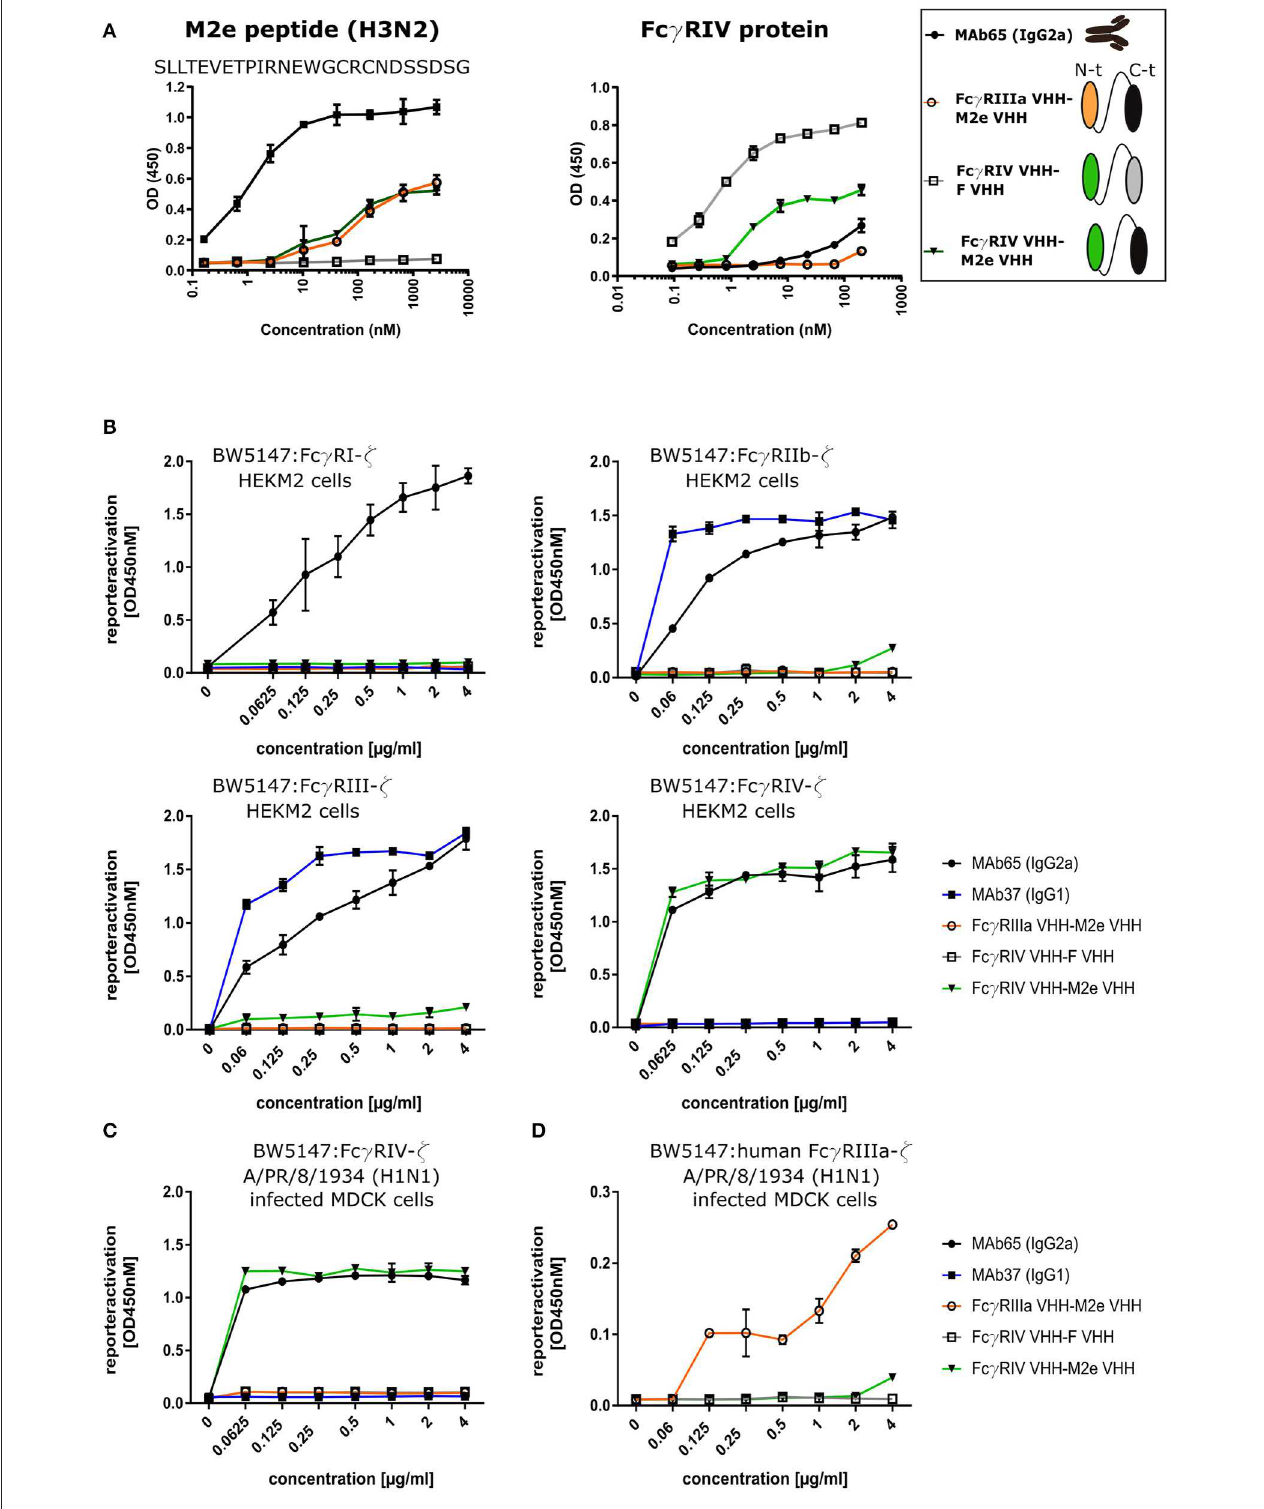
FIGURE 6 | Bispecific fusion construct of anti-mouse Fc γ RIV VHH with M2e-VHH-23m selectively activates Fc γ RIV in vitro . (A) Schematic representation ofthebispecificVHHsandELISAonhumanH3N2M2epeptideandrecombinantFc γ